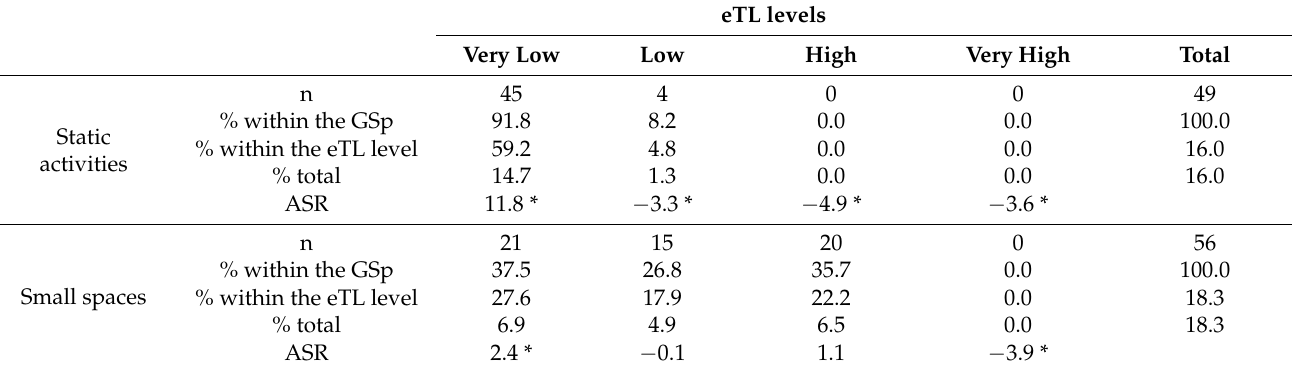
Table 3. Descriptive results and ASRs of the task-induced eTL, depending on the game